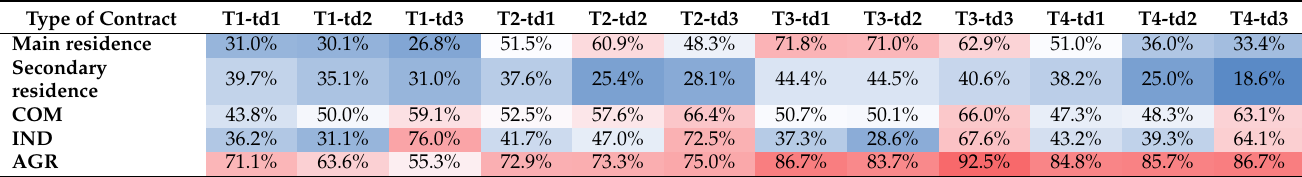
Table 4. Number of the right customer/cluster associations for the customer included in the DB2017. Type of